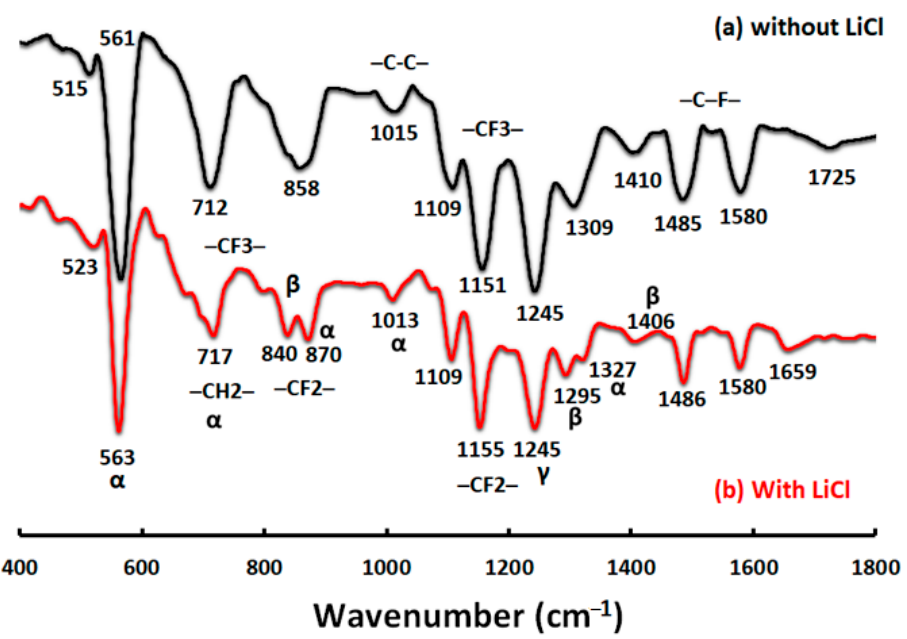
Figure 13. Fourier transfer infrared spectroscopy-attenuated total reflectance (FTIR-ATR) analyses of blend PcH/PES membranes using a NMP/DMF solvents mix without ( a ) and with ( b ) LiCl additive.